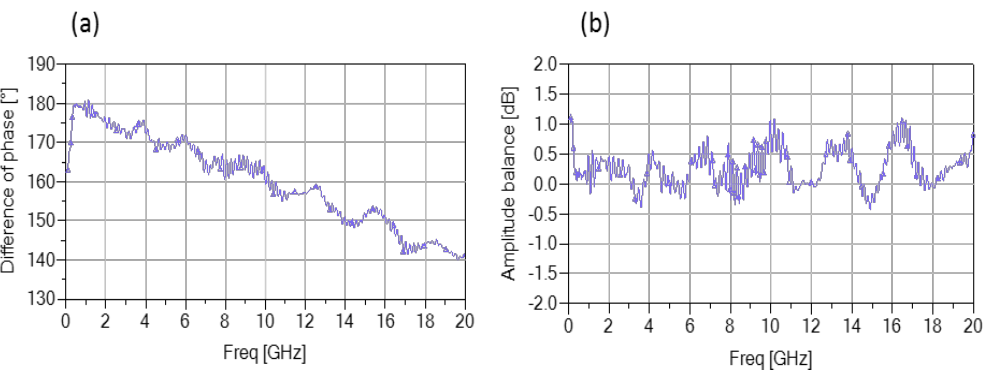
Figure 4. Three port S parameters measurement up to 20 GHz using a PNAX: ( a ) phase difference between the two outputs; ( b ) amplitude balance between the two outputs.